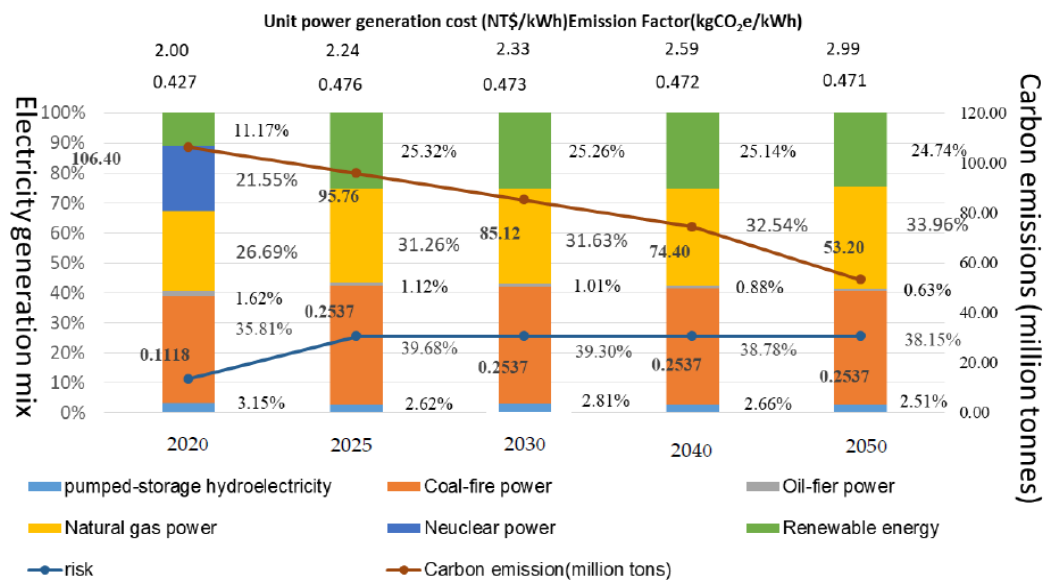
Figure 2. The optimal power generation technology mixed (2020 – 2050) in Taiwan. Source: This research.